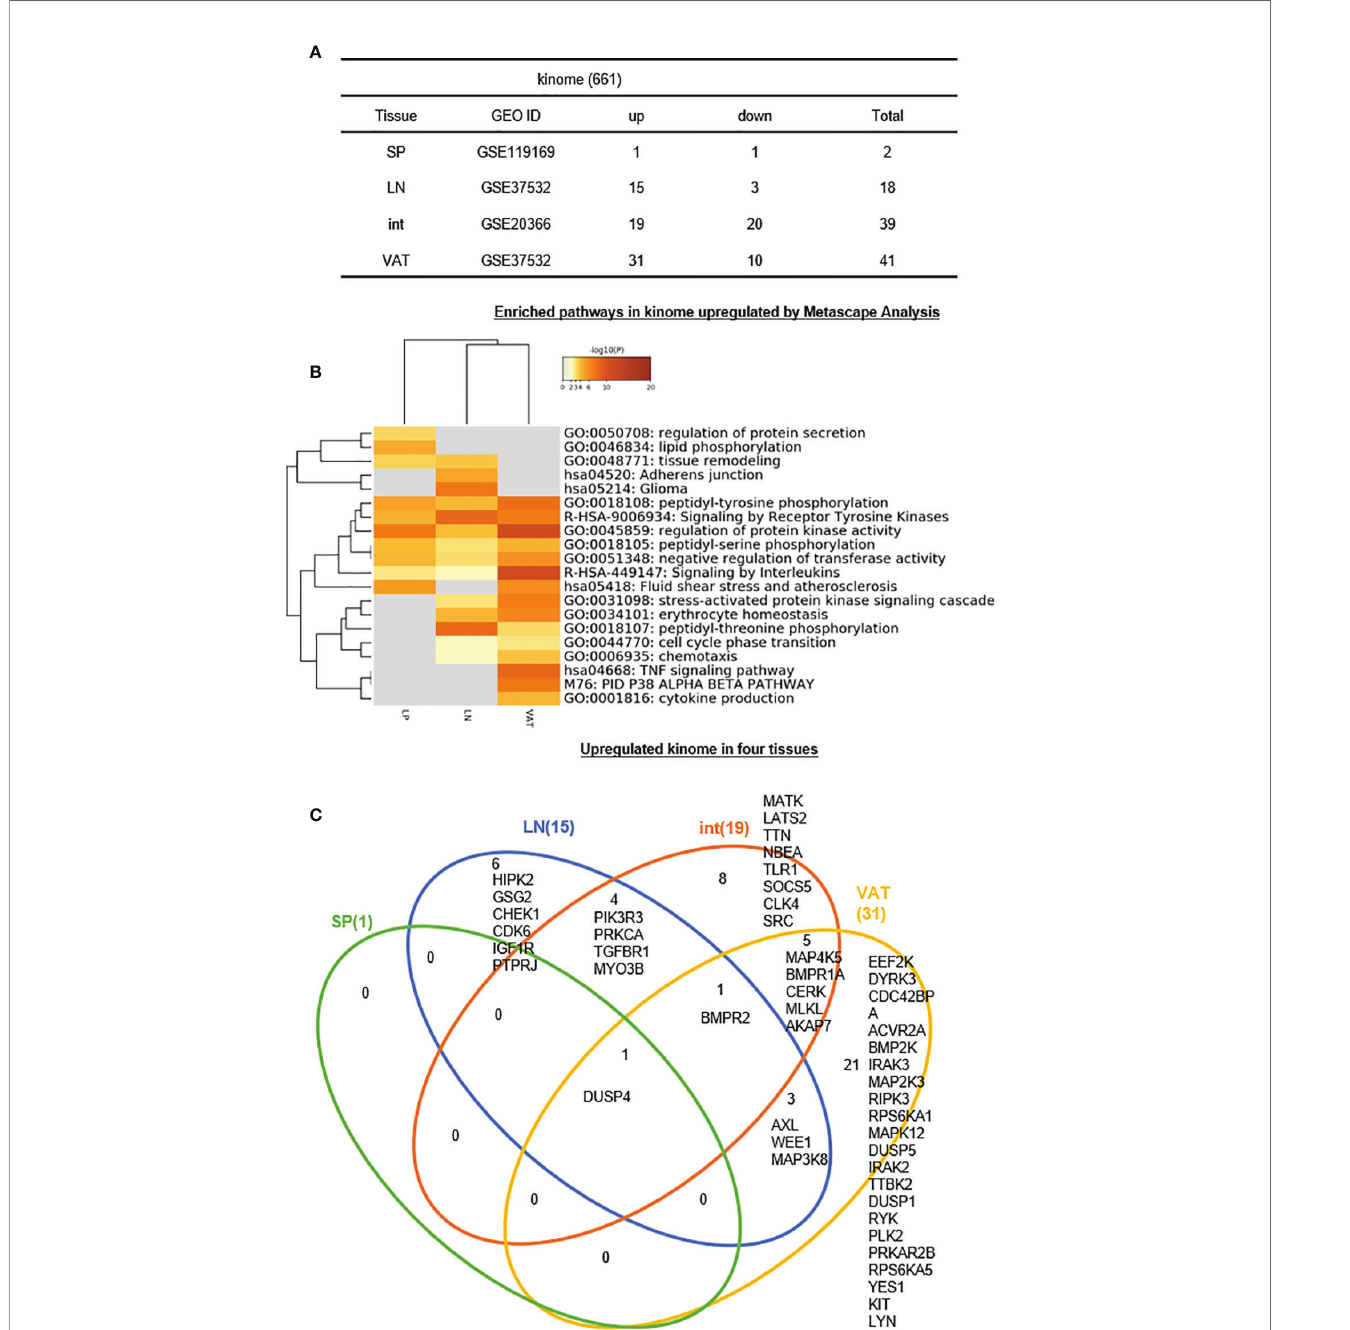
FIGURE 9 | (A – C) Six lymph nodes Treg speci fi c kinases, eight intestine Treg-speci fi c kinases, and 21 VAT Treg-speci fi c kinases are identi fi ed, which mediate 20 immune signaling pathways after screening for total 661 human kinome expression changes of kinome pro fi le were analyzed in our study. See the detailed data in Supplementary Figure 8